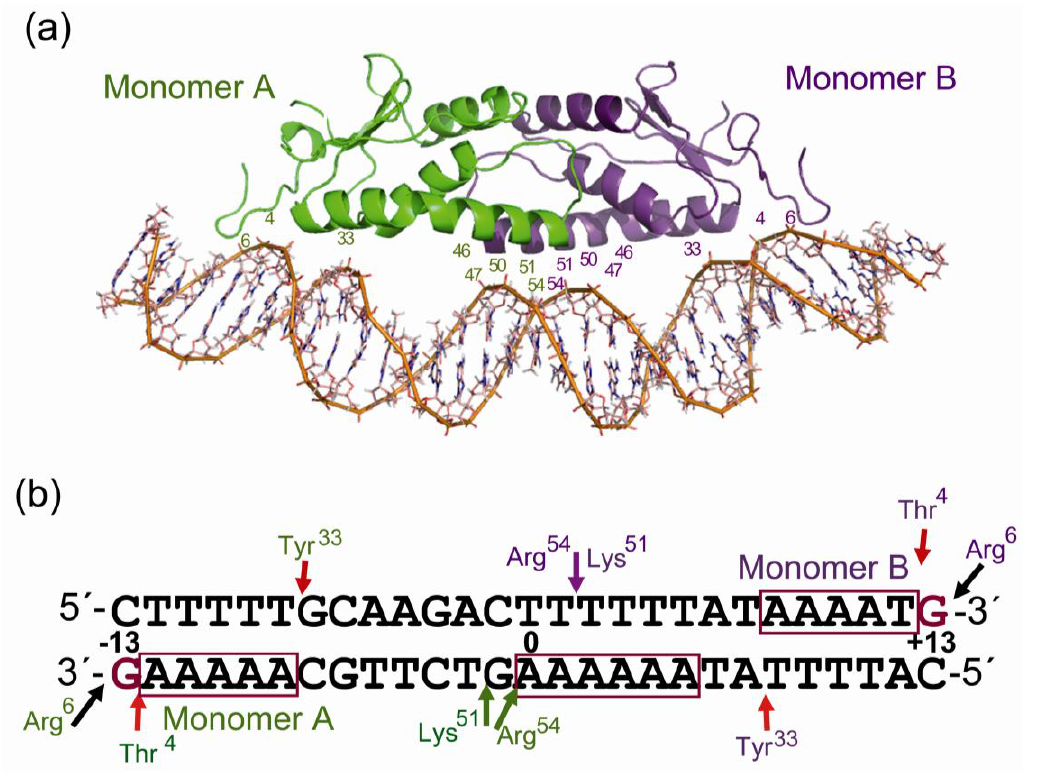
are represented in green and purple, and each monomer is distinguished as A (green) or B (purple) depending on its position with respect to the terminal repetition of site 3.